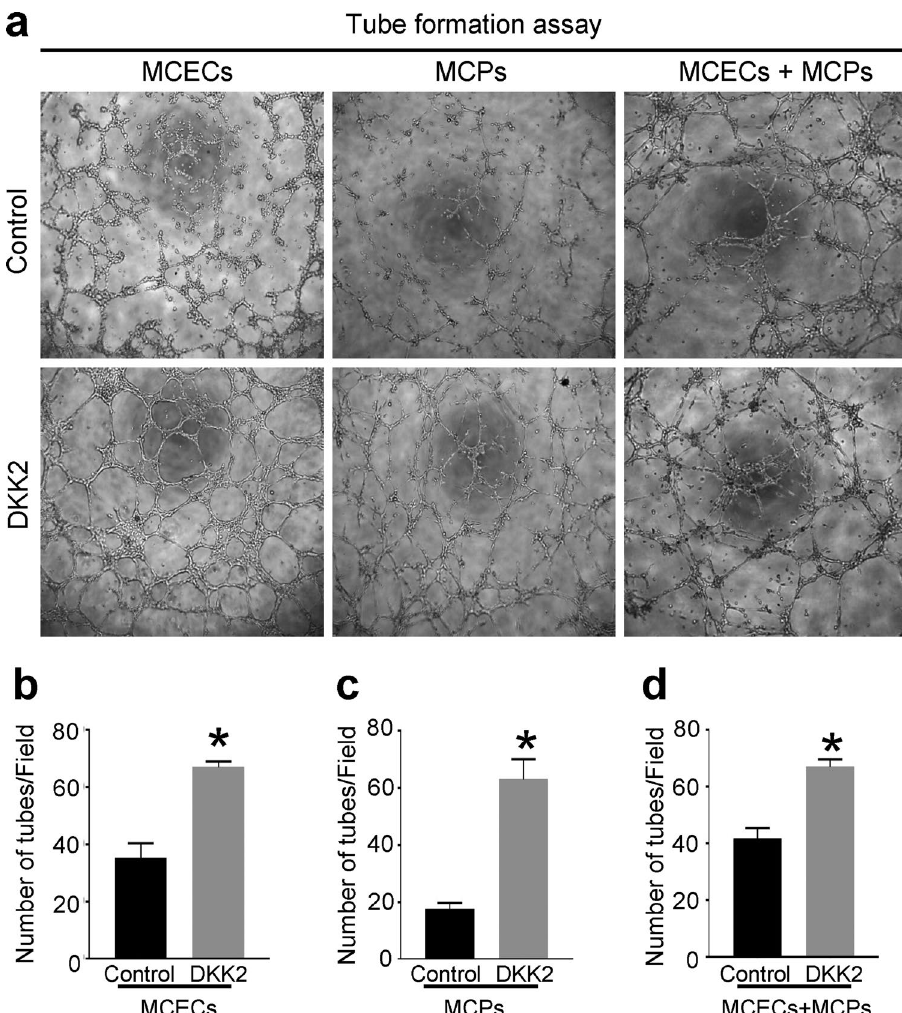
Figure 6. DKK2 enhances tube formation. (a) Tube formation assay in primary cultured mouse cavernous endothelial cells (MCEC) and pericytes (MCP) mono-culture system or in MCEC-MCP co-culture system, which were treated with PBS or DKK2 protein (300 ng/ml). (b–d) Number of tubes per high-power field. Each bar depicts the mean ( ± SE) values from n = 4 independent experiments. * P < 0.001 vs. control group. DKK2 =